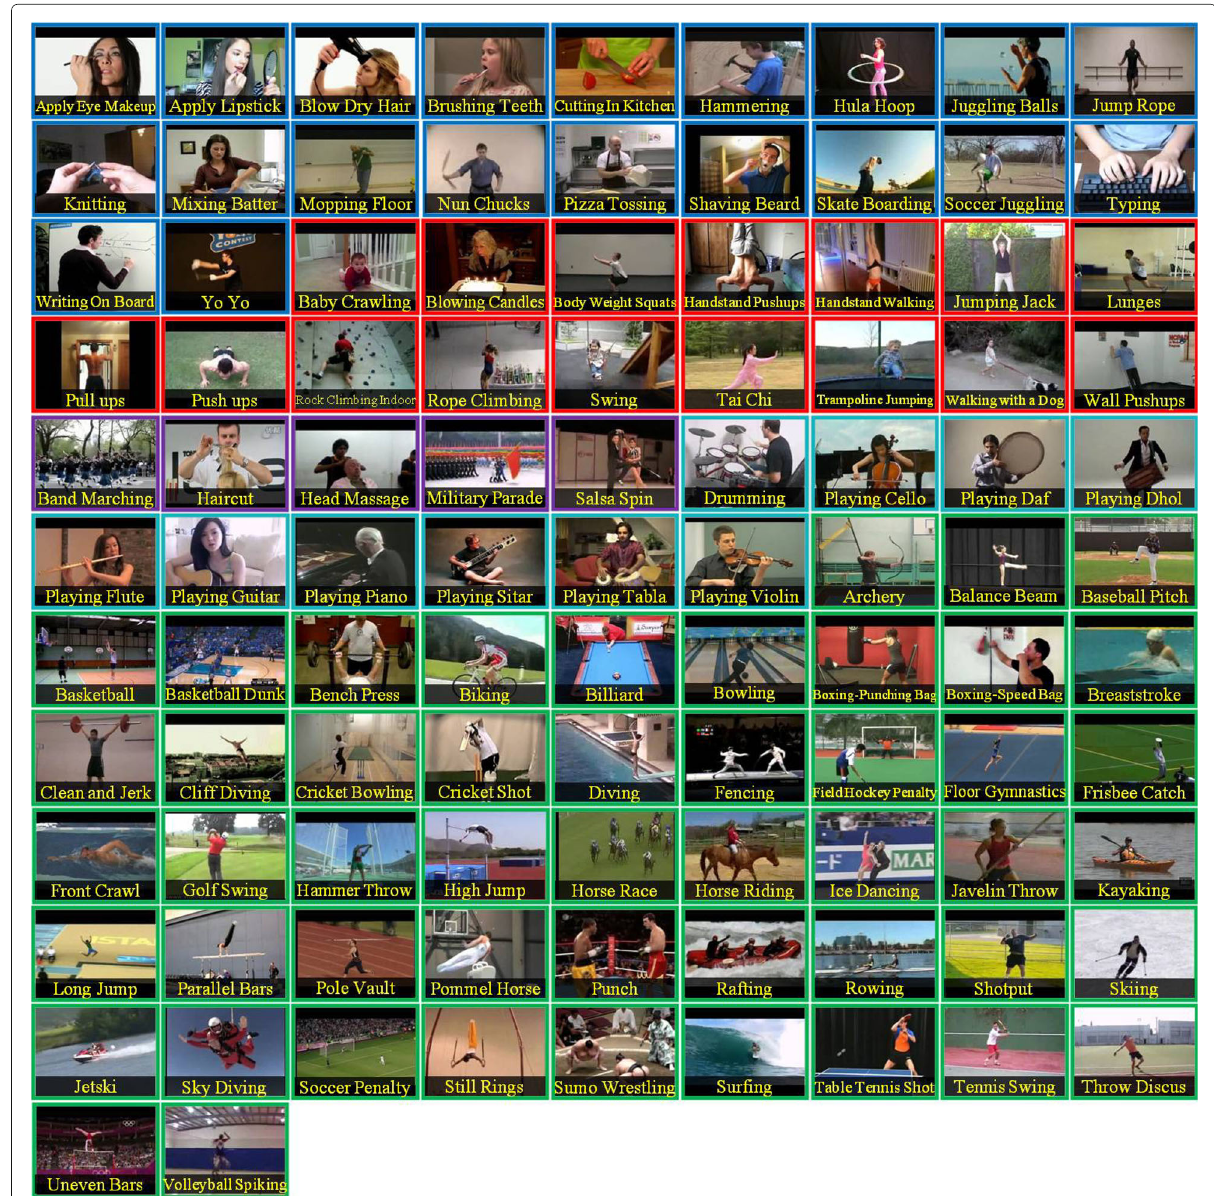
Fig. 4 UCF 101 dataset containing 101 action classes with 9537 training videos and 3783 testing videos